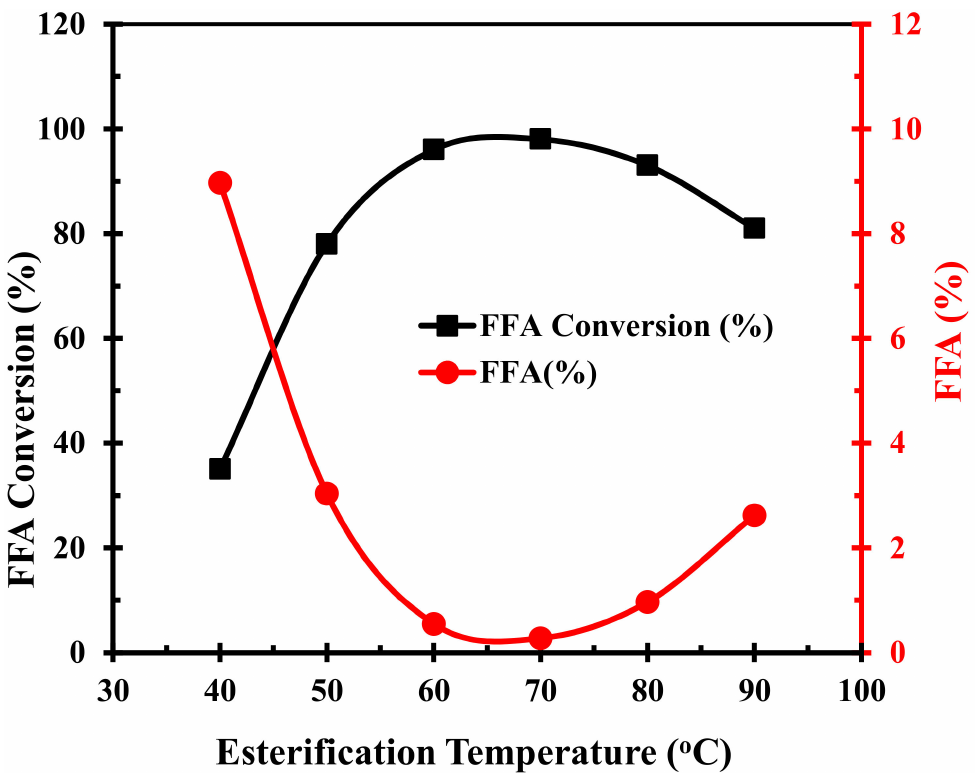
Figure 8. Effect of the reaction temperature on FFA conversion to FAME and